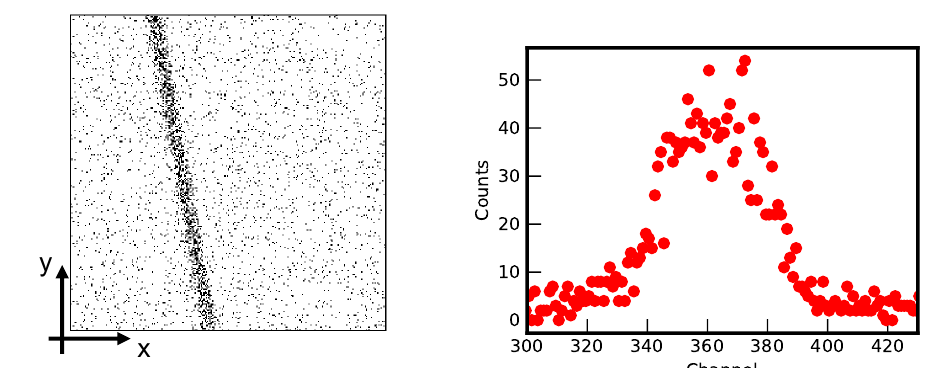
Figure 1. Spectral line corresponding to the He-like uranium 1 s 1/2 2 p 3/2 → 1 s 1/2 2 s 1/2 intrashell transition obtained by a Bragg spectrometer. ( Left ): 2D spectrum from the spectrometer X-ray CCD with a binning of 8. The dispersion axis corresponds to the x-axis with x proportional to the wavelength of the photon. ( Right ): Projection on the dispersion axis after line slope